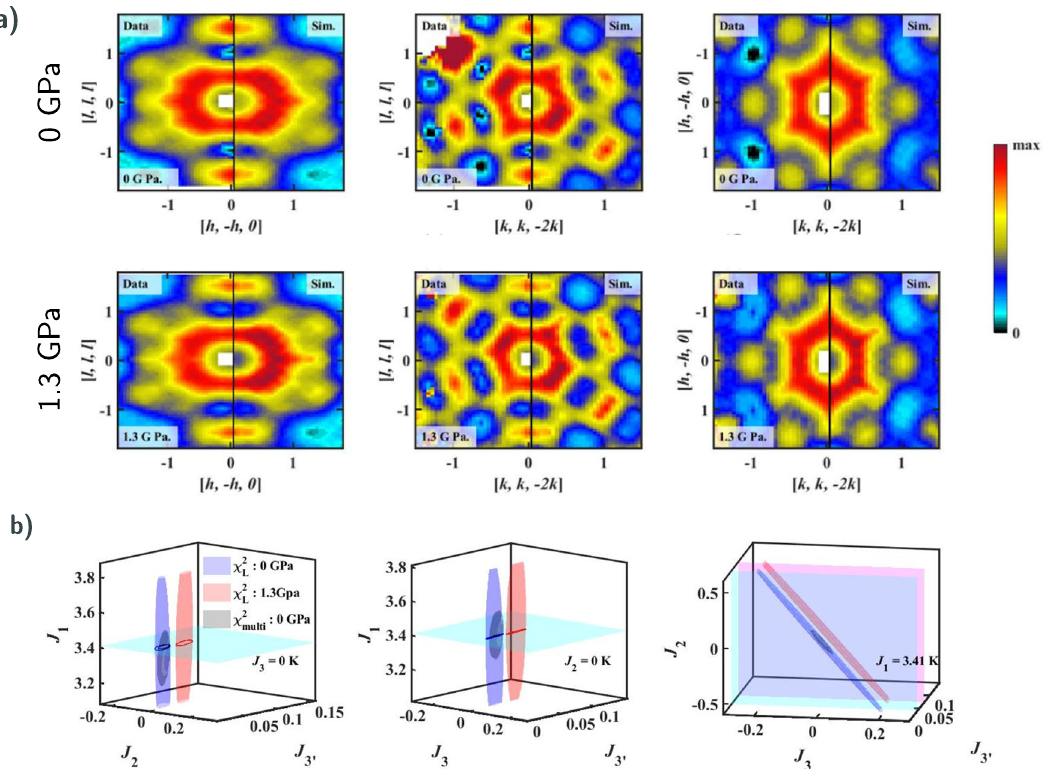
Fig. 3 Comparison of magnetic structure factor from both experiment and theory at different pressure and parameter fi t. a Three perpendicular slices of 3D volumes of S exp ð Q Þ are shown for 0 GPa (top) and for 1.3 GPa (bottom). Each panel is a side-by-side comparison of experiment (left) and simulation (right). All data was collected at T = 0.68 K. Notice that the simulations exclude nuclear Bragg peaks, not relevant for the magnetic structure investigated here. b Three 3D slices of 4D solution manifolds with J 3 = 0 K, J 2 = 0 K and J 1 = 3.41 K respectively. The coloured contours denote the the region in parameter space that best fi t S exp ð Q Þ at 0 GPa (blue) and 1.3 GPa (red). Black contours denote the combined uncertainty for the fi t to S exp ð Q Þ and the heat capacity ( C v ) at 0 GPa. The light blue plane indicates the usually accepted value of J 1 = 3.41K. Both J 1 and 3 J 2 − J 3 are ill-constrained by S exp ð Q Þ , yet the relation